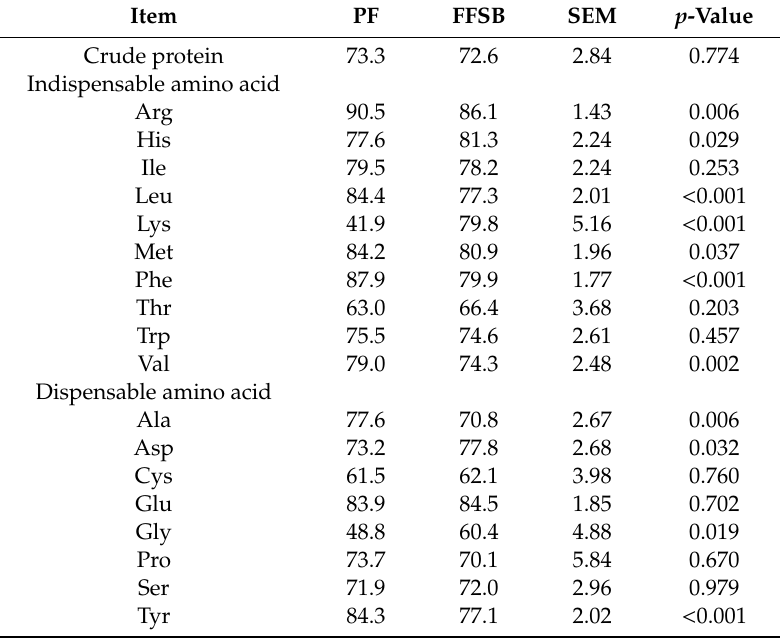
Table 7. Apparent ileal digestibility (%) of crude protein and amino acids for experiment 2 1,2